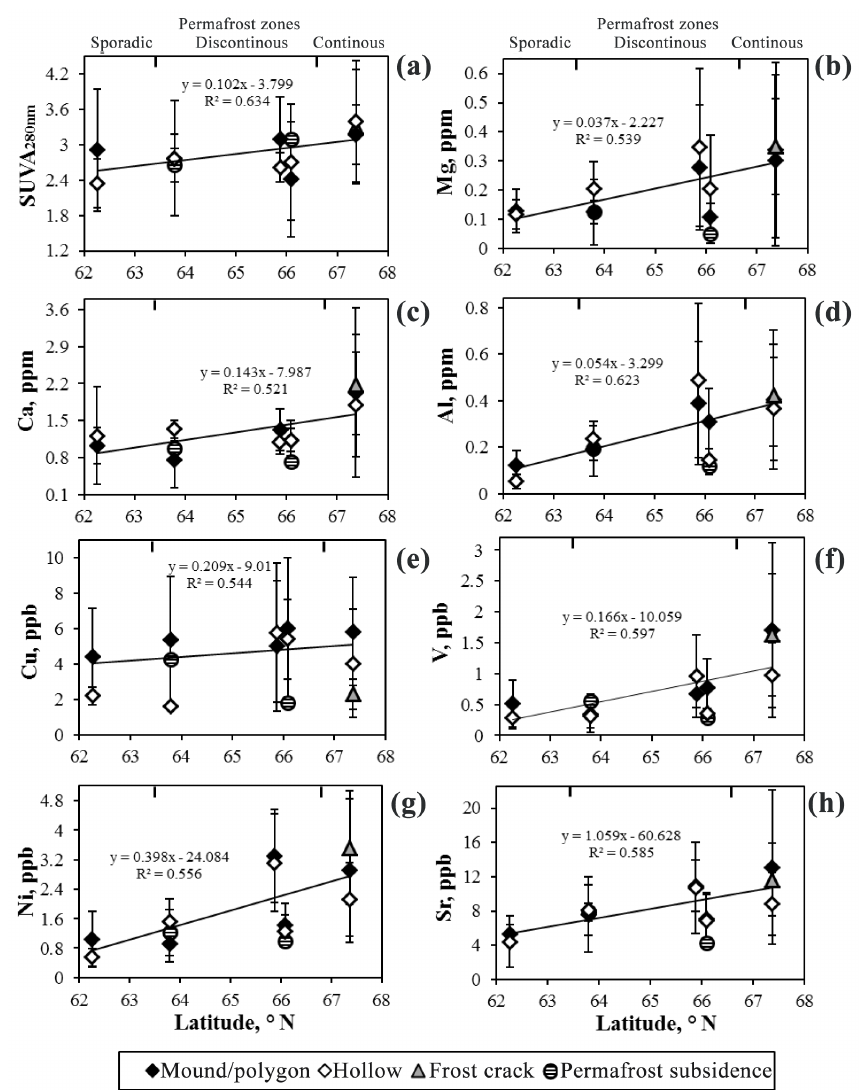
Figure 4. Mean values of SUVA 280 (a) , Mg (b) , Ca (c) , Al (d) , Cu (e) , V (f) , Ni (g) , and Sr (h) concentration in peat porewaters of the WSL as a function of latitude for mound and polygons (solid diamonds), hollow (open diamonds), frost crack (grey triangles), and permafrost subsidence/depression (hatched circles). The solid line is a linear fit to all data with the regression equation given on each